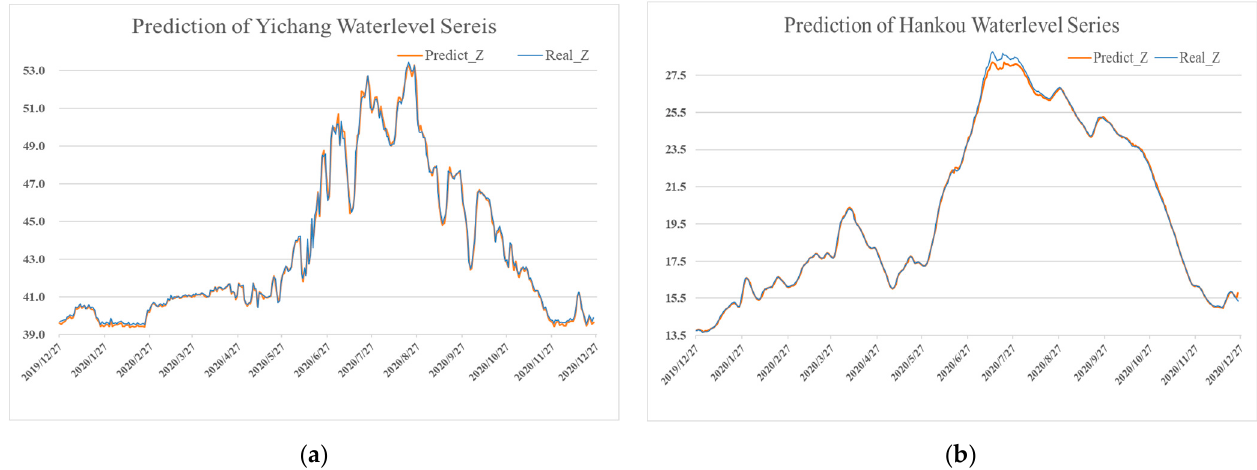
Figure 5. The prediction and observation data of water level series. ( a ) The predicted result for Yichang Hydrological Station; ( b ) the predicted result for Hankou Hydrological Station.